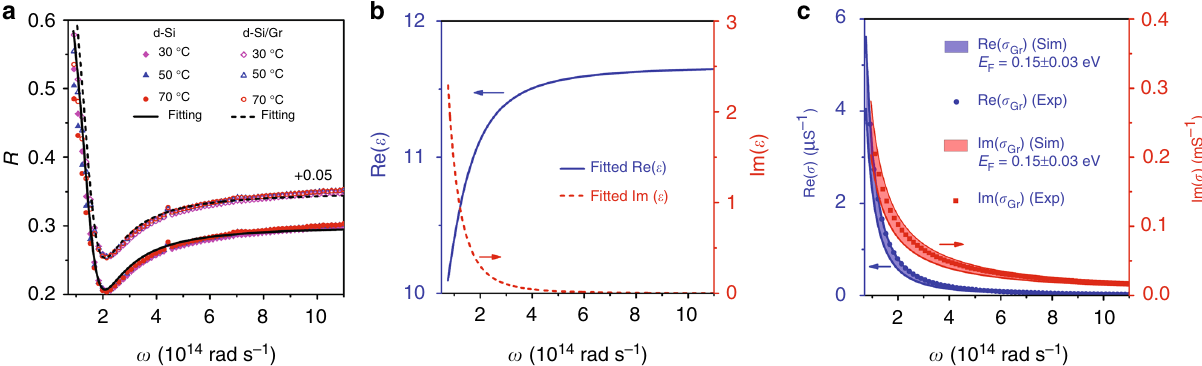
Fig. 4 Characterization of d-Si/Gr properties. a The measured re fl ection spectra of the d-Si and d-Si/Gr samples at different temperatures. We have intentionally shifted up the value of d-Si/Gr by + 0.05 for better vision. The black solid/dashed line is the fi tting curve by considering a Drude conductivity model for both Si and graphene in the far-mid-IR range. b The retrieved real (blue) and imaginary (red) parts of permittivity for the doped silicon substrate. c The retrieved real (blue dots) and imaginary (red squares) parts of sheet conductivity for the graphene layer. The shaded regions represent the theoretical conductivity distribution calculated using E F = 0.15 ± 0.03 eV. Figure 4 by Yang J et